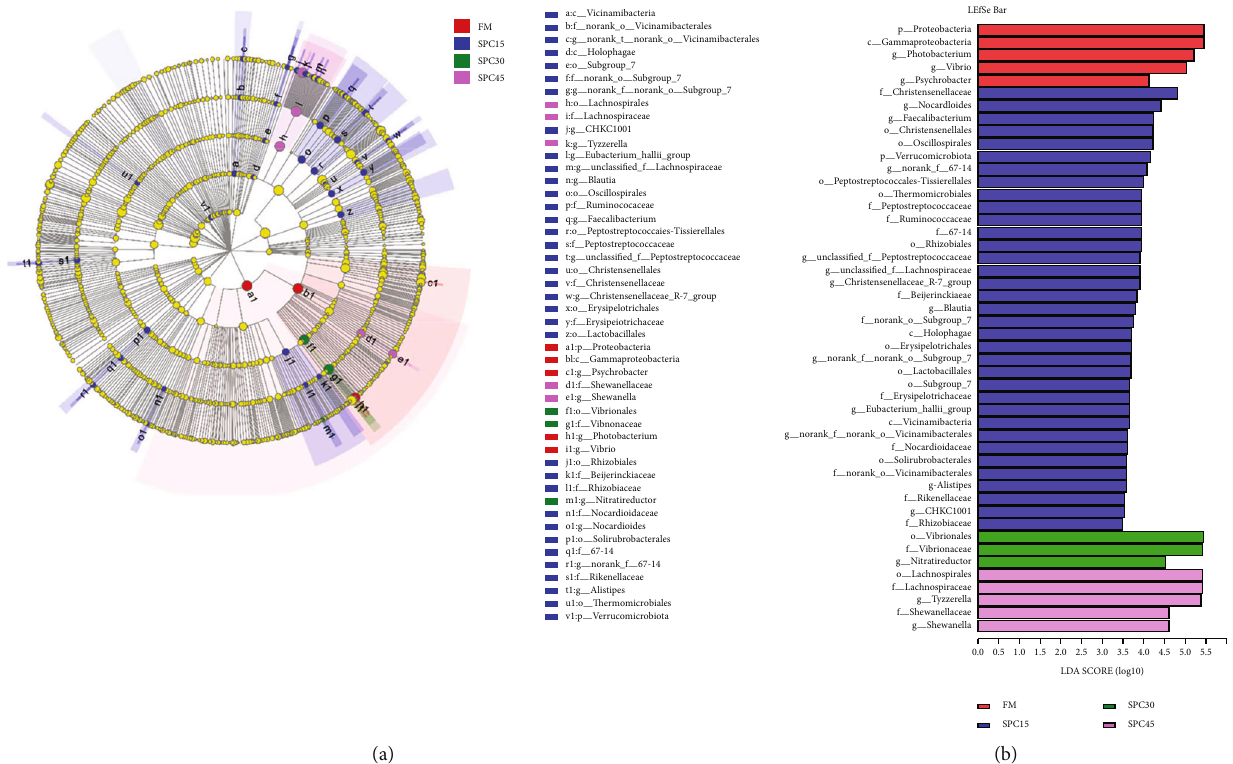
Figure 6: LEfSe analysis identi fi ed the most di ff erentially abundant taxons between large yellow croakers fed di ff erent experimental diets. (a) Cladogram was calculated by LefSe. (b) Histogram of linear discriminant analysis (LDA) scores for di ff erentially abundant taxon. Di ff erences were presented by the color of the most abundant taxa (red, blue, green, and purple indicated one taxon with signi fi cantly higher relative abundance in FM, SPC15, SPC30, and SPC45 treatments, respectively).